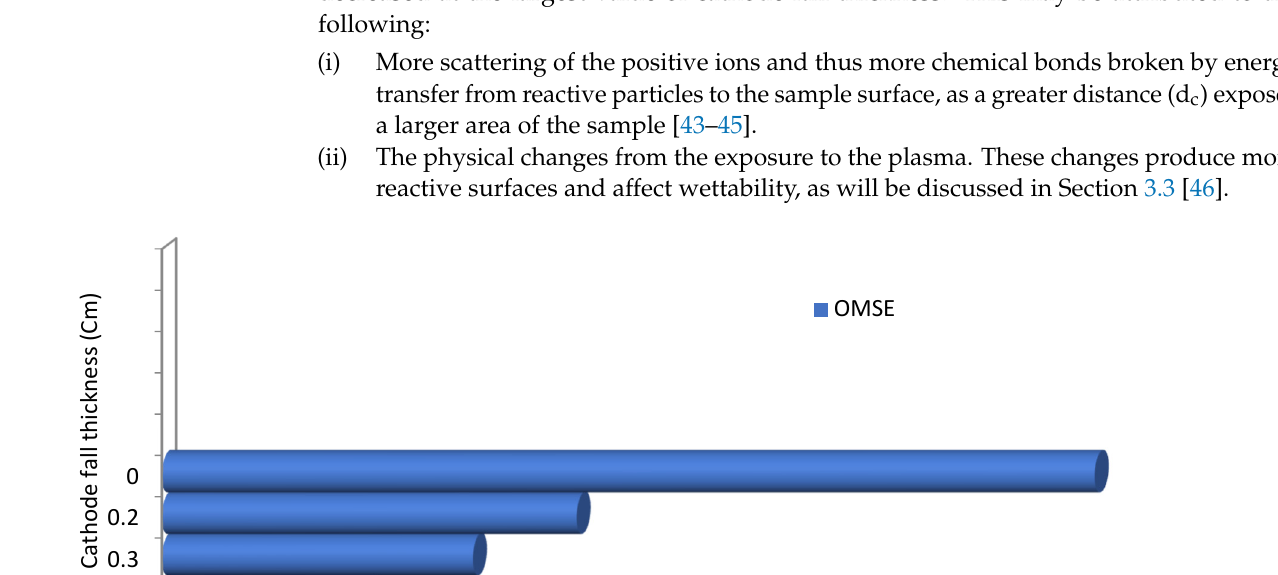
Figure 10. The wettability of the surgical gown as a function of exposure time for the different plasma cell configurations OMSE and OMTSE with applied pressure of 1 mTorr and cathode fall thickness of 0.25 cm.